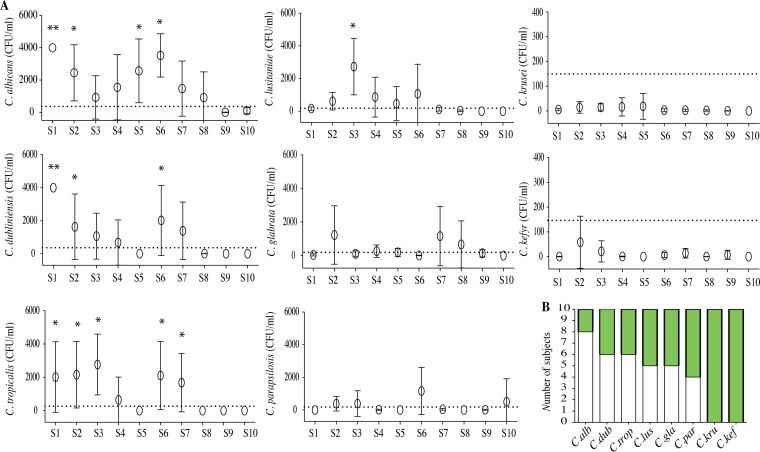
Interindividual variability of the response against Candida spp. The variability of the subjects' response against Candida infection was studied after infection of human peripheral blood mononuclear and polymorphonuclear cells with living yeasts from different Candida species. (A) Fungal burden 6 days postinfection. Results are expressed as the mean ± SEM of the fungal burden of 4 Candida clinical isolates from each species for each subject (S1 to S10). Dotted lines indicate the arbitrary cutoff of 100 CFU/ml. The mean ± SEM for each subject and each Candida species were compared to the mean ± SEM of species that controlled infection (mean of C. krusei and C. kefyr). *, P < 0.05; **, P < 0.001. (B) Number of subjects showing a persistent-infection (white bars) or controlled-infection (green bars) status.